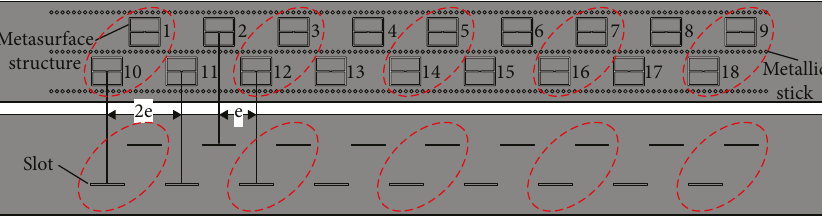
Figure 6: Simulated S